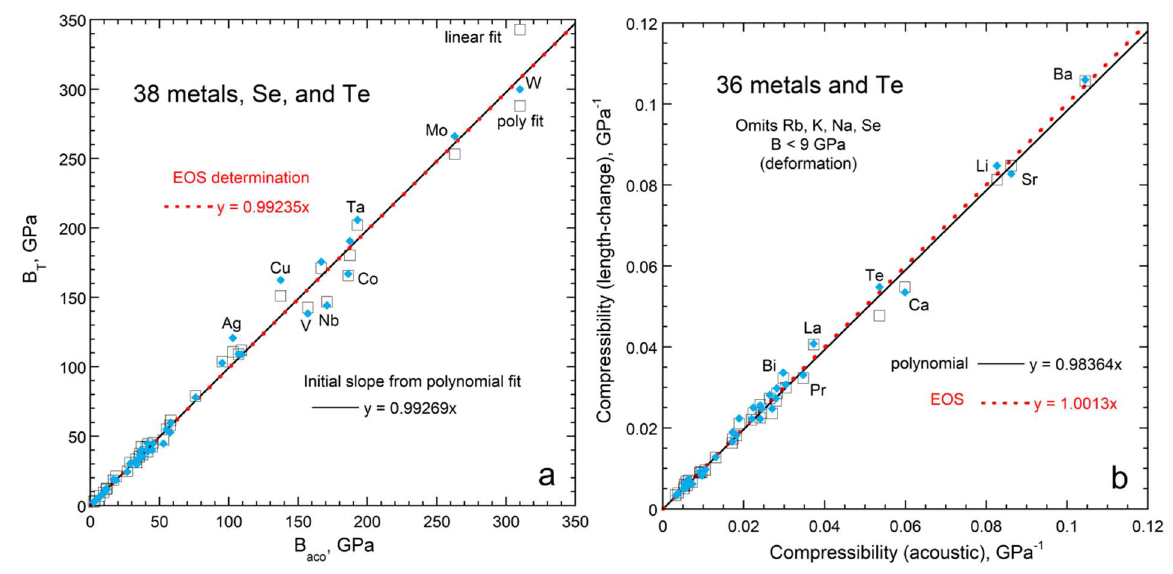
Figure 7. Comparison of different measures of metal bulk moduli. Length-change measurements from [31,46,47] were fit to EOS by the authors and to 2nd order polynomials here. Most acoustic determinations are from compilations listed in Figure 5. Vaidya and Kennedy [47] provide additional acoustic data: ( a ) direct comparison. Both linear and polynomial fits are fit for tungsten, because curvature in V ( P ) was not resolved. Gold was not measured, but the other noble metals have relatively large B T ; ( b ) inverse comparison. The four softest metals were excluded because these not only needed 1–3 more terms for accurate fitting, but more importantly, the sigmoidal dependence of their V on P indicated deformation. We did not fit the initial slope because the lowest P data may be affected by slight deformation.